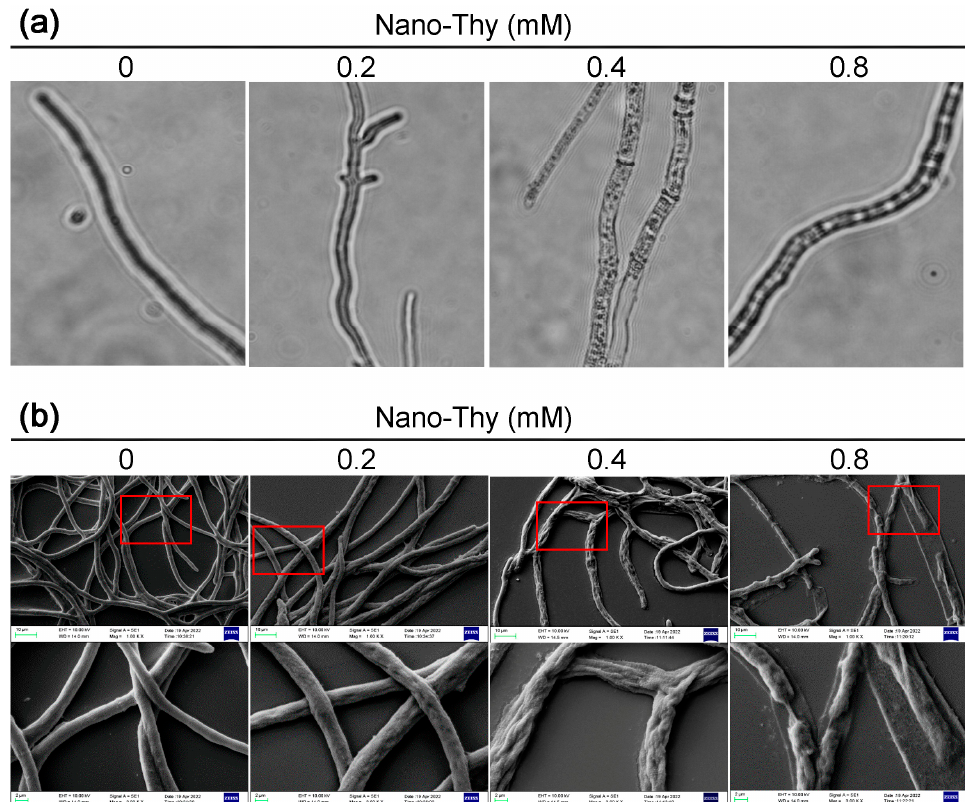
Figure 6. The effect of Nano-Thy on the morphology of B. cinerea mycelia. ( a ) Observation of mycelium with optical microscope; ( b ) Observation of mycelia with SEM.